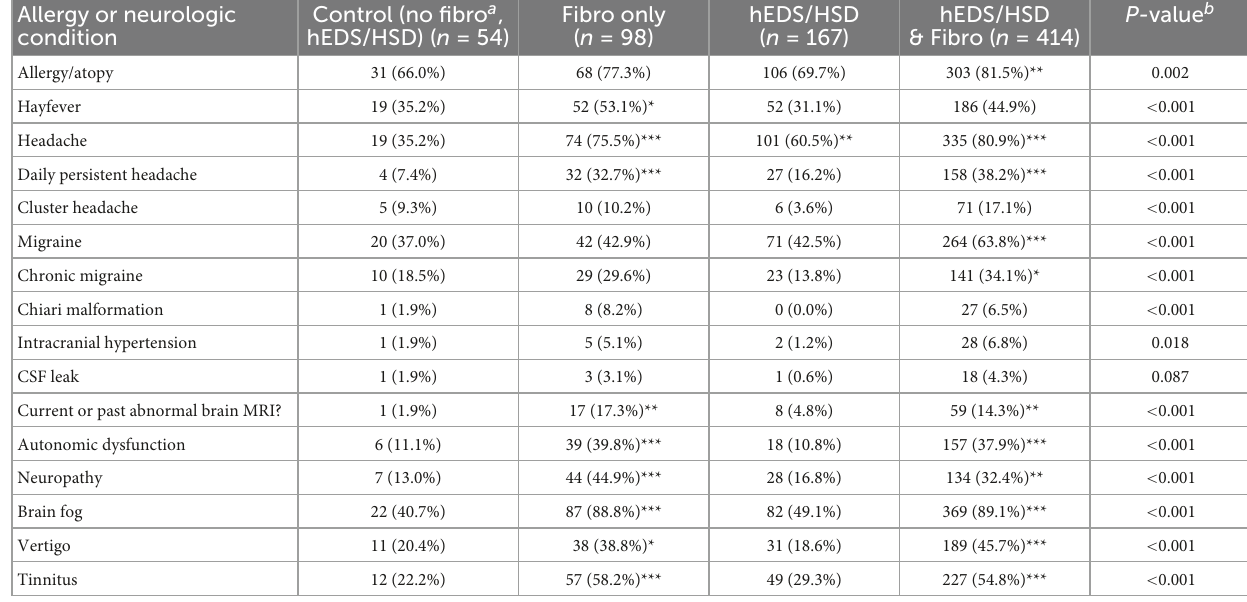
TABLE 4 Allergy, headaches, migraine, and related conditions in female and male patients diagnosed with fibromyalgia, hypermobility (hEDS or HSD) or hEDS/HSD and fibromyalgia compared to controls ( n = 733). Allergy or neurologic condition Allergy/atopy